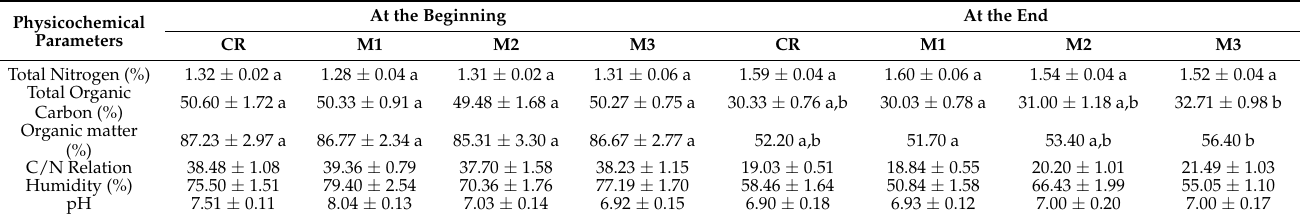
Table 2. Vermicomposting process physicochemical composition.